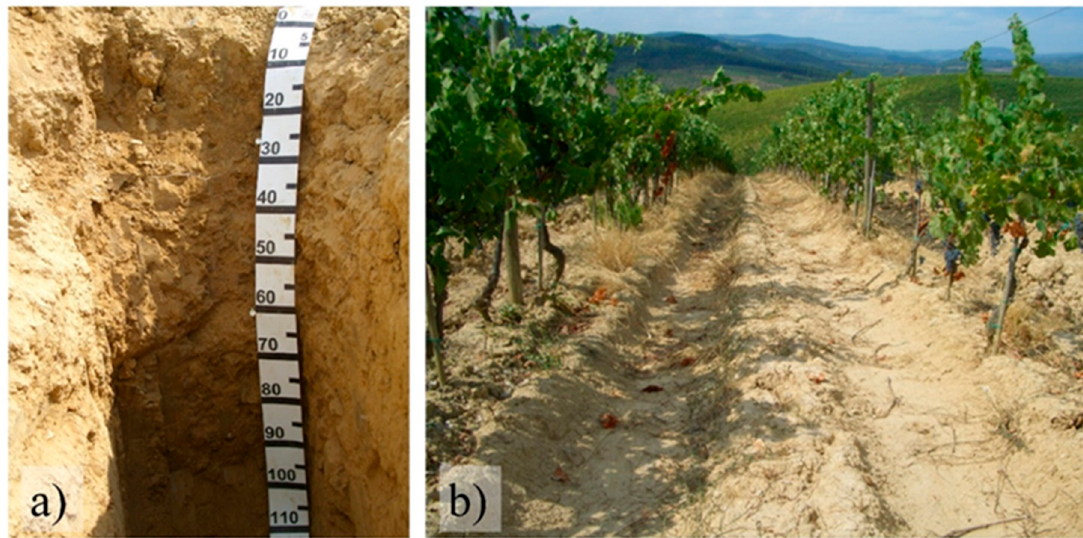
Figure 1. Soil compaction in a vineyard with sodic soil (clay loamy, pH: 8.9, ESP: 42.6) which limits the grapevine growth ( b ). On the left, the related soil profile, where the scarce structure of the soil horizons is evident ( a ).